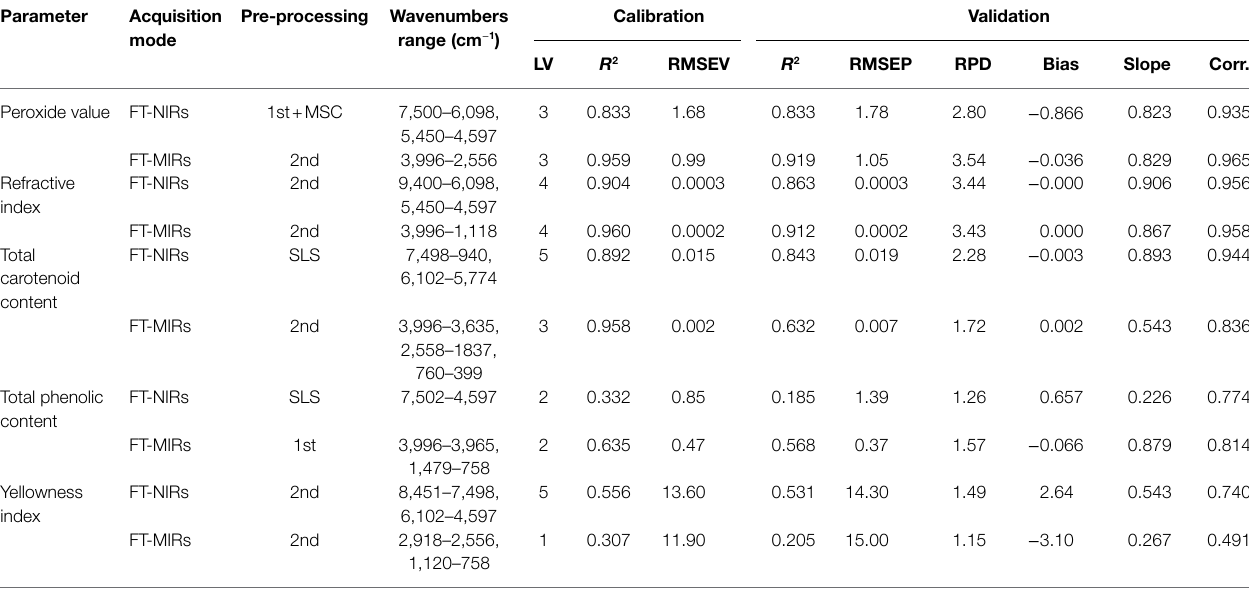
TABLE 2 | Model evaluation statistics for quality parameters of pomegranate kernel oil as determined from FT-NIR and FT-MIR spectroscopy (sample number = 42).